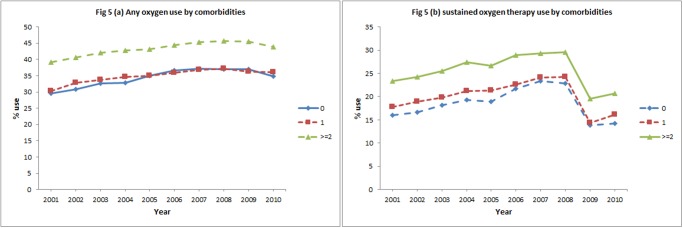
Any oxygen use by comorbidities, (a), and sustained oxygen therapy use by comorbidities, (b).